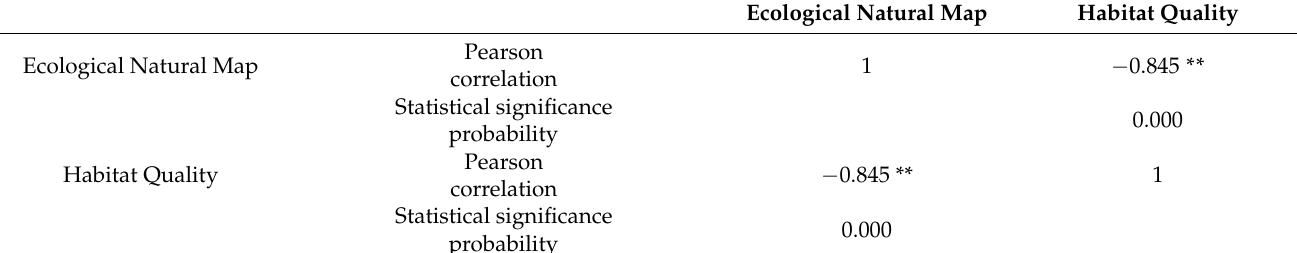
Table 8. Correlation coefficient between the ecological natural map and habitat quality.